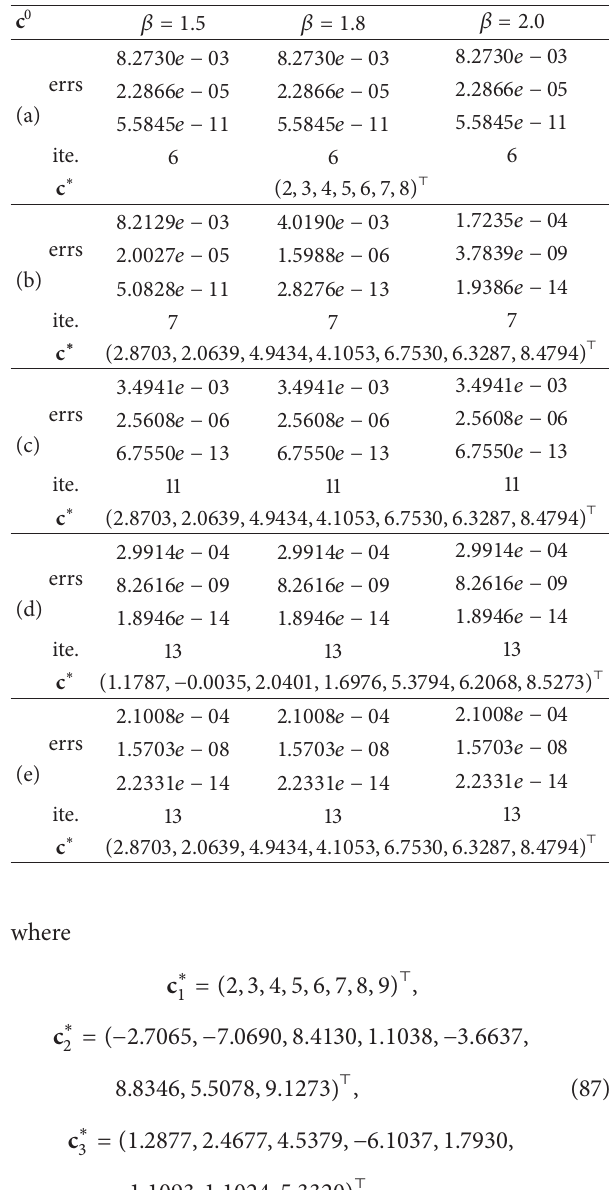
Table 2: Numerical results for Example